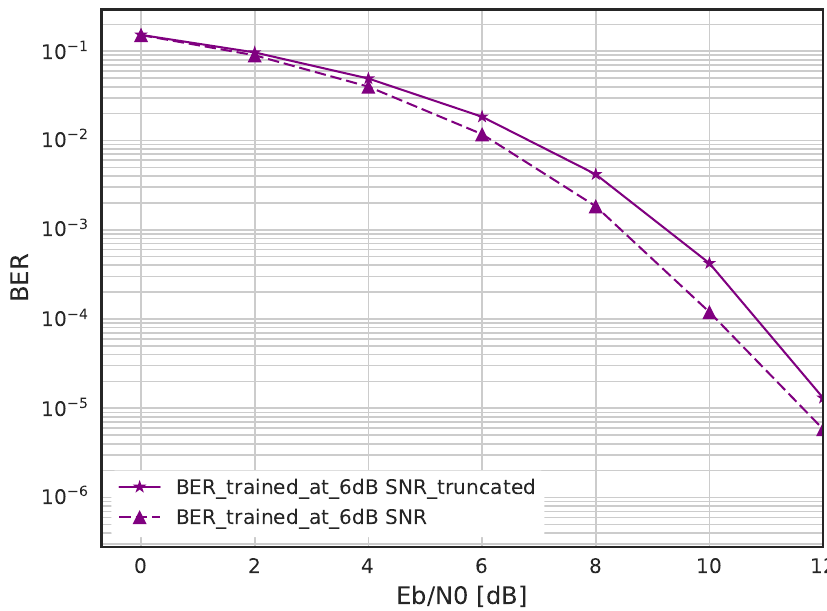
Figure 11. BER performance for Gaussian and truncated Gaussian noise when η = − 6 dB.